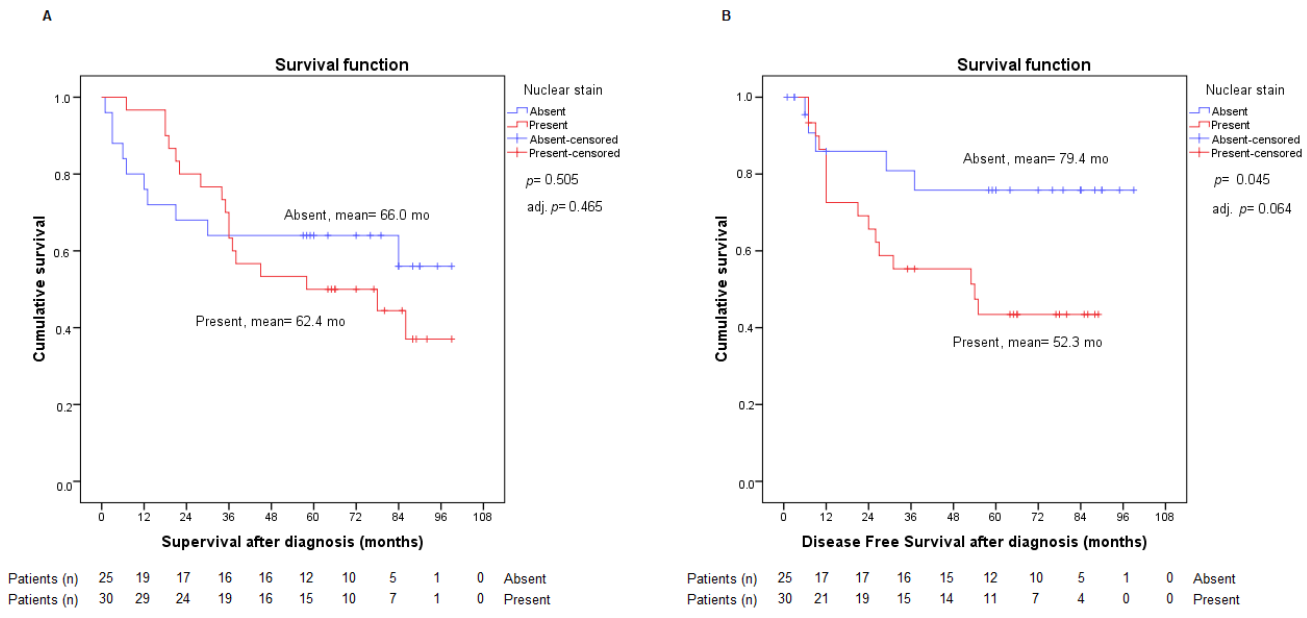
Figure 6. Analysis of overall survival ( A ) and disease-free survival ( B ) according to absent or present TGF- β nuclear staining. Adj. p : p -value from Cox regression model adjusted by stage.